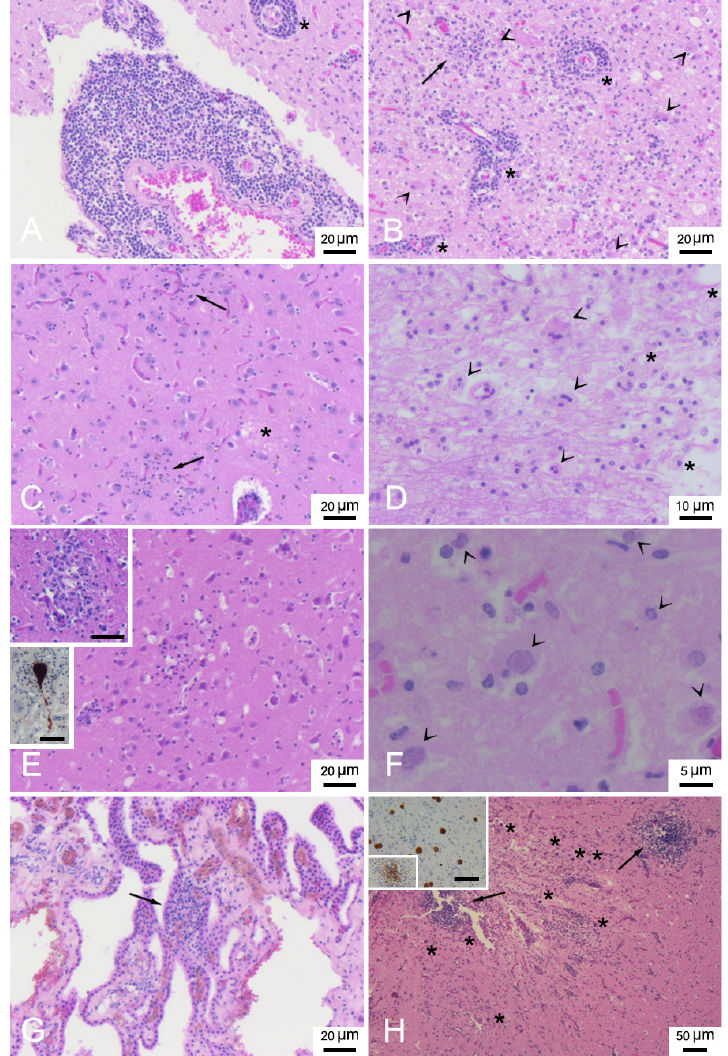
Figure 2. Neuropathologic lesions in stranded cetaceans with DMV infection. ( A ) Frontal cortex (ID 19). Severe non-suppurative meningitis and perivascular cuffing (asterisk). HE. ( B ) Frontal cortex (ID 19). Severe encephalitis with non-suppurative perivascular cuffing (asterisks), neuronophagic nodule of microglia cells (arrow) and diffuse astro-microgliosis with gemistiocytes (arrowheads). HE. ( C ) Frontal cortex (ID 16). Microgliosis (arrows) and oedema (asterisk), HE. ( D ) Cerebellum (ID 7). Malacic area with gitter cells (asterisks) and syncytia cells (arrowheads), HE. ( E ) Parietal cortex (ID 31). Diffuse acute neuronal necrosis (eosinophilic and shrunken neurons) and microgliosis. Upper inset: occipital cortex (ID 24). Neuronophagic nodule of microglia cells. Scale bar = 20 μ m. HE. Lower inset: pons (ID 16). Positive labelling of a neuron inside a neuronophagic nodule. Scale bar = 25 μ m. IHC for DMV. ( F ) Occipital cortex (ID 19). Eosinophilic intranuclear inclusion bodies (arrowheads). HE. ( G ) Plexus choroideus (ID 14). Focal and minimal non-suppurative plexus choroiditis (arrow). HE. ( H ) Frontal cortex (ID 16). Severe necrotizing granulomatous encephalitis with protozoan cysts (asterisks) and two nodules of microglia and mononuclear inflammatory cells (arrow). HE. Inset: Frontal cortex (ID 16). Positive labelling of a nodule of microglia and mononuclear inflammatory cells and several protozoan cysts. Scale bar = 50 μ m. IHC for Toxoplasma gondii .